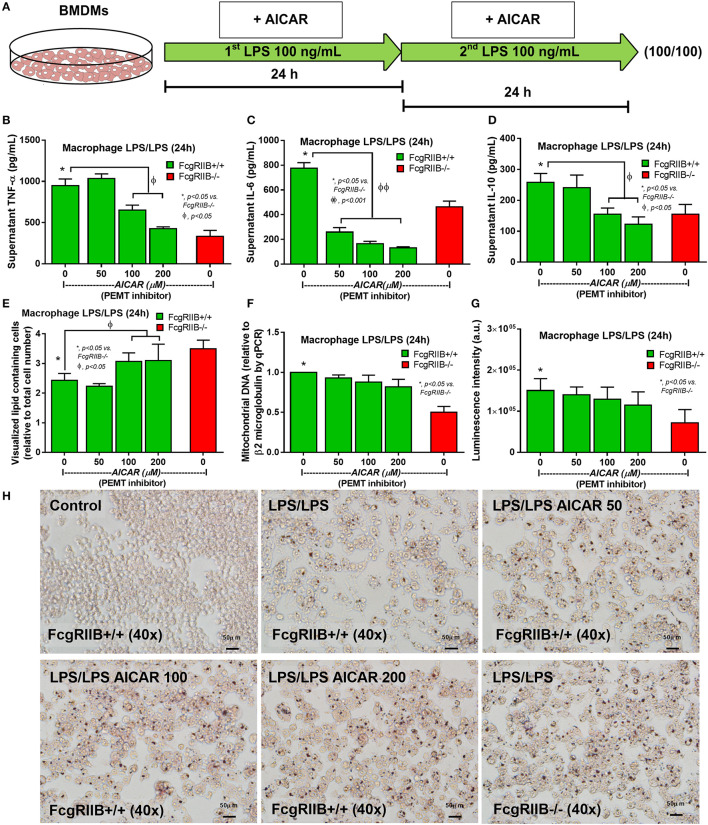
Schematic diagram (A) of the experiment with LPS-tolerance induction (LPS/LPS) in wild-type (FcgRIIB+/+) bone marrow-derived macrophages (BMDMs) with aminoimidazole-4-carboxamide ribonucleotide (AICAR; a pemt inhibitor) compared with LPS-tolerant FcgRIIB–/– macrophages as determined by supernatant cytokines (B–D), number of lipid droplets intensity from Oil Red O staining by ImageJ software evaluation (E), semi-quantitative expression of mitochondrial DNA content (mtDNA) relative to β2 microglobulin (β2M) gene by qRT-PCR (F), luminescence intensity of cellular ATP production (G), and the representative Oil Red O staining (H) from these cells after the stimulations are demonstrated. Independent triplicate experiments were performed.